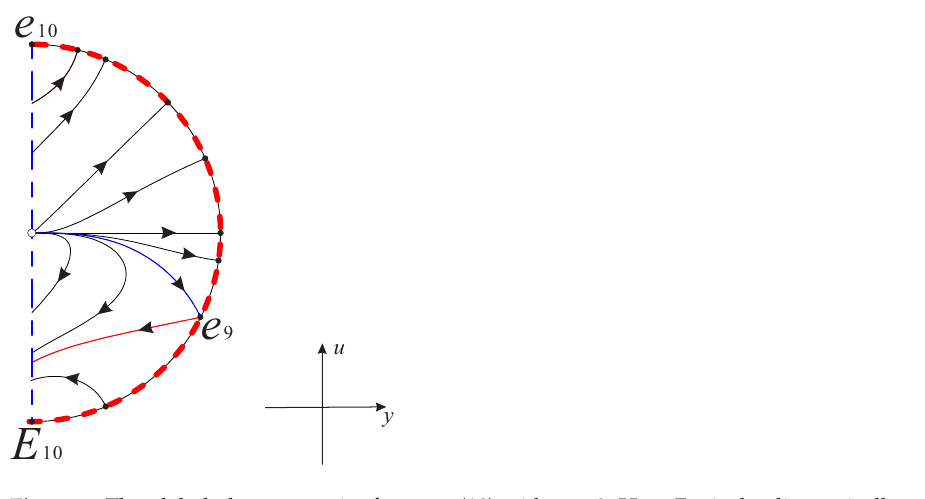
Figure 8. The global phase portrait of system (18) with y > 0. Here E 10 is the diametrically opposite equilibrium point of e 10 at infinity.